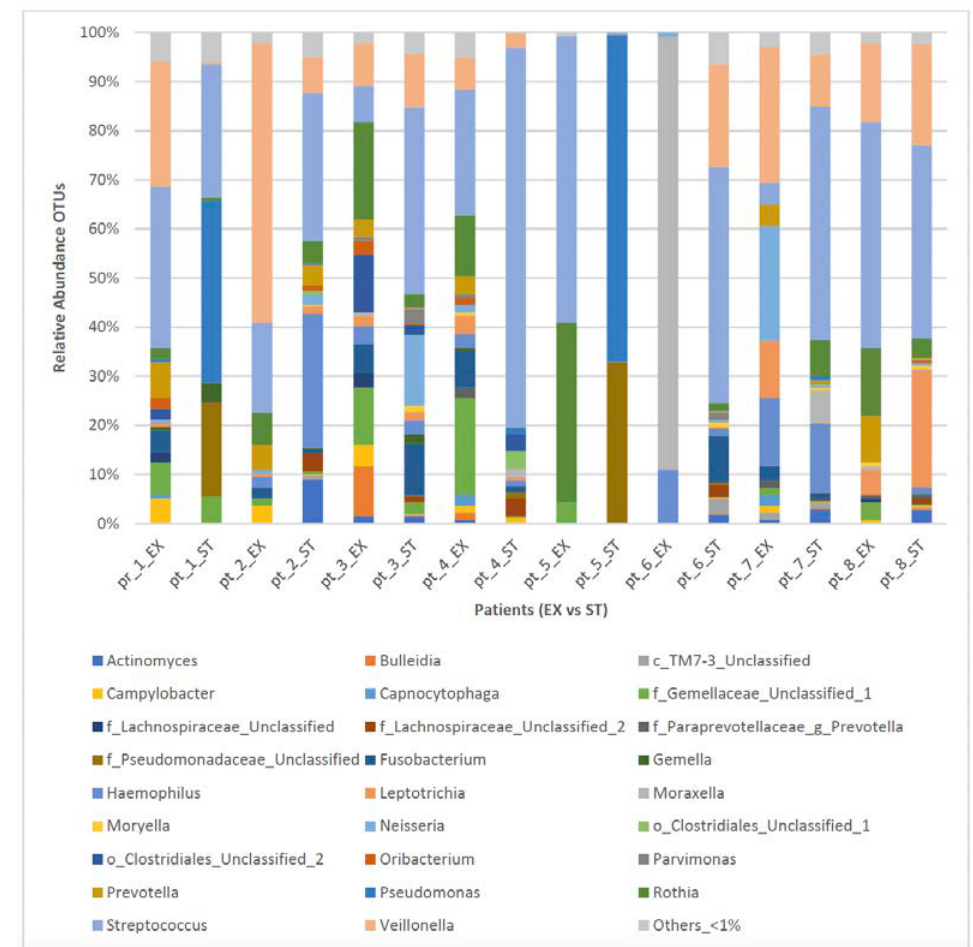
Figure 3. Bacterial taxa distribution (genera-level) of sputum samples from eight ACO patients in the EX versus ST states. Taxa name with “unclassified” suffix might not be assigned to the level of genus and are shown at the lowest known taxon. ST: stable; EX: exacerbation. Table 4. The presence or absence of each genus in the EX and ST states in the study.